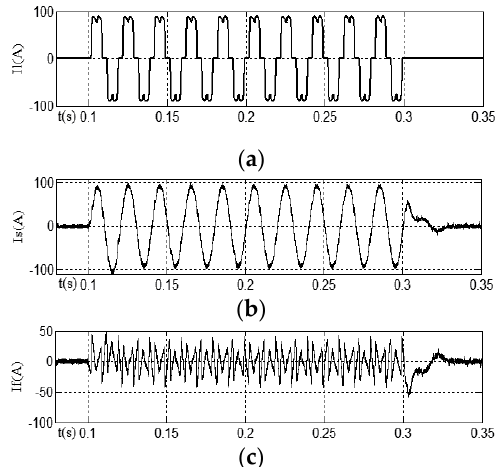
Figure 7. Dynamic performance of the APF system. ( a ) Load current I l ; ( b ) Source current I s ; ( c ) Harmonic current I f . ( c ) Harmonic current I f .